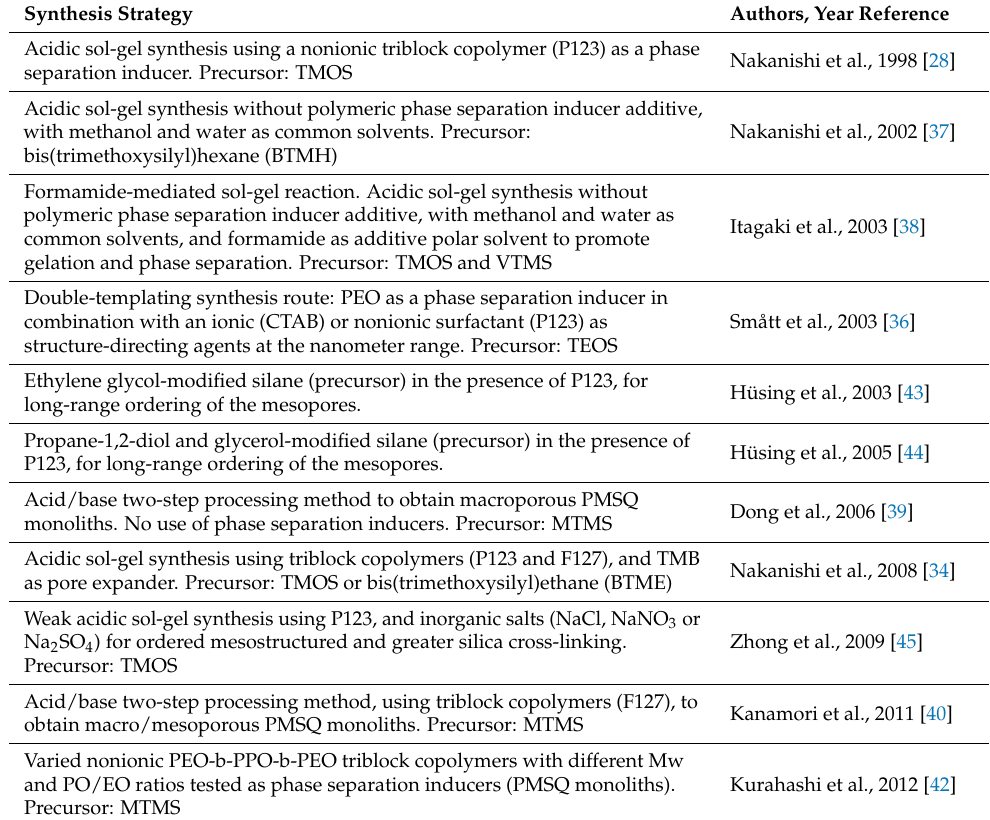
Table 1. Overview of some of the latest developments on SiO 2 macro and mesoporous hierarchically structured monoliths (inorganic and hybrid composition) prepared via sol-gel/phase separation